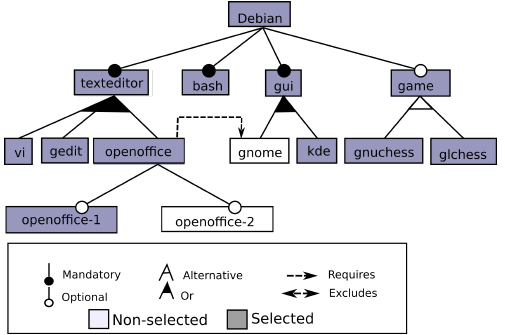
Figure 7. Feature model of a Debian derivative with a non-valid configuration (gray features). Table 6. Q UICK XP LAIN execution tracking on configuration example of Figure